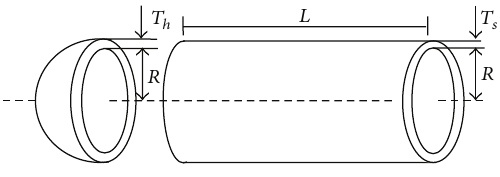
Figure 2: Pressure vessel.